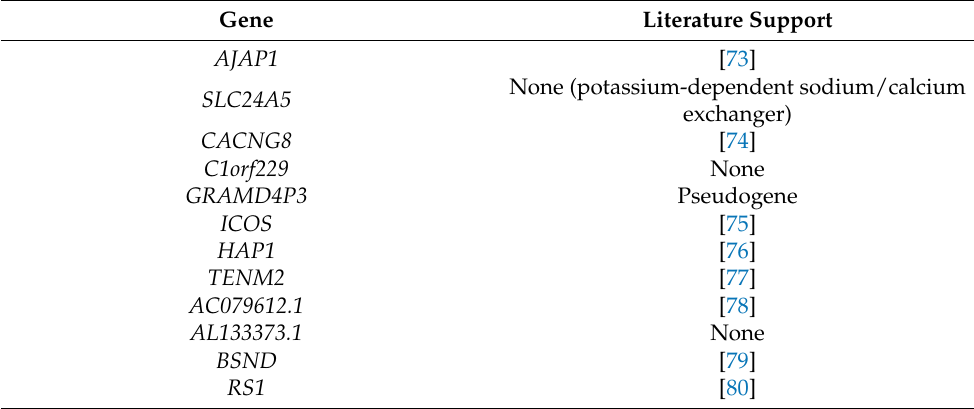
Table 3. Top Risk Decreasing Genes Identified by TCGA-COAD Cox model: List of the top risk decreasing genes identified by our Cox model on the TCGA-COAD dataset.